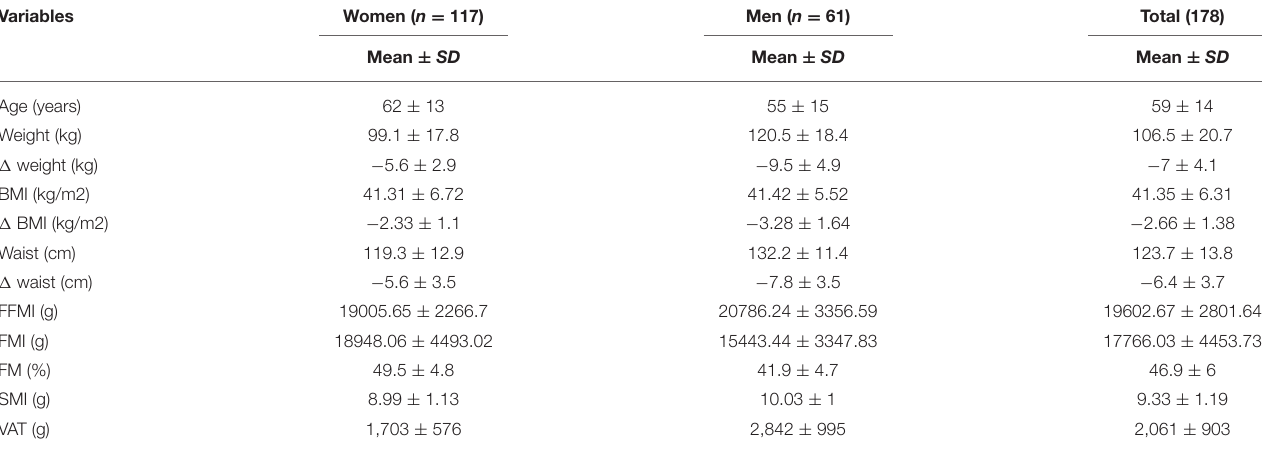
TABLE 1 | Baseline anthropometric measurements.